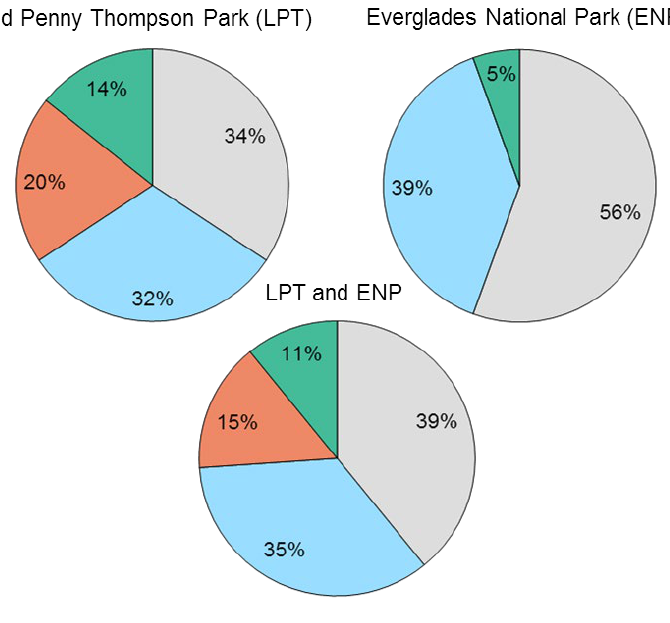
Figure 7. Relative occurrence of the four visitor behaviors observed on flowers of Guettarda scabra , among arthropod species in pine rockland habitats in south Florida, USA. Percentages represent the fraction of species observed engaging in a particular behavior on flowers, with respect to the total number of species found in Larry and Penny Thompson LPT (35 species), in Everglades National Park ENP (18 species), or in both sites combined (46 species).